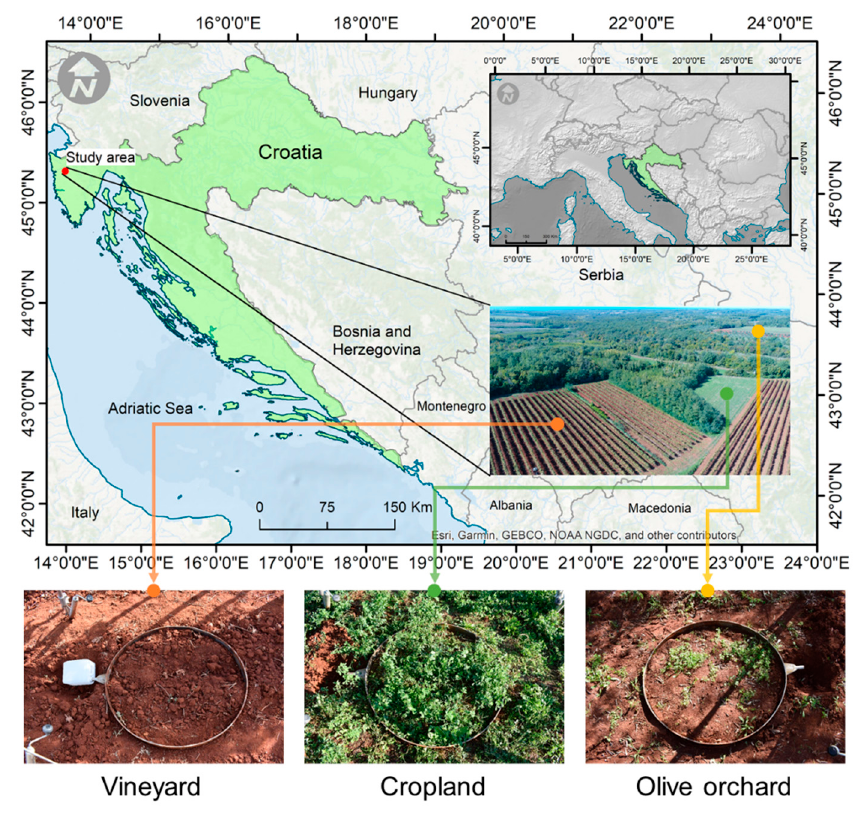
Figure 1. Study area.